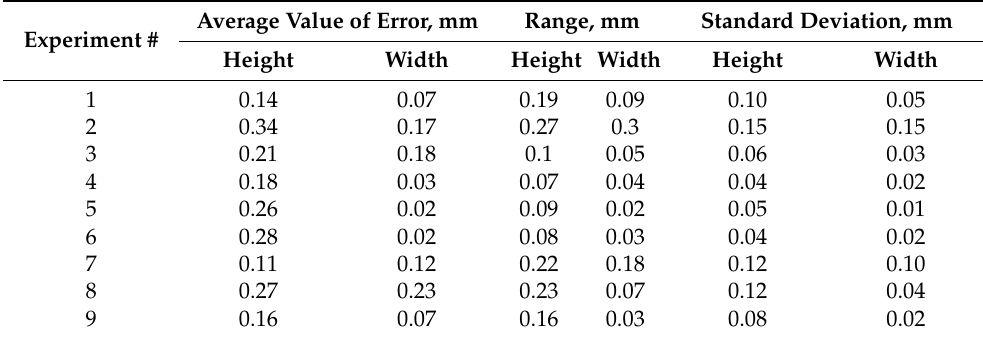
Table 4. The results of measurements taken from 3D printed 20 × 20 × 20 mm